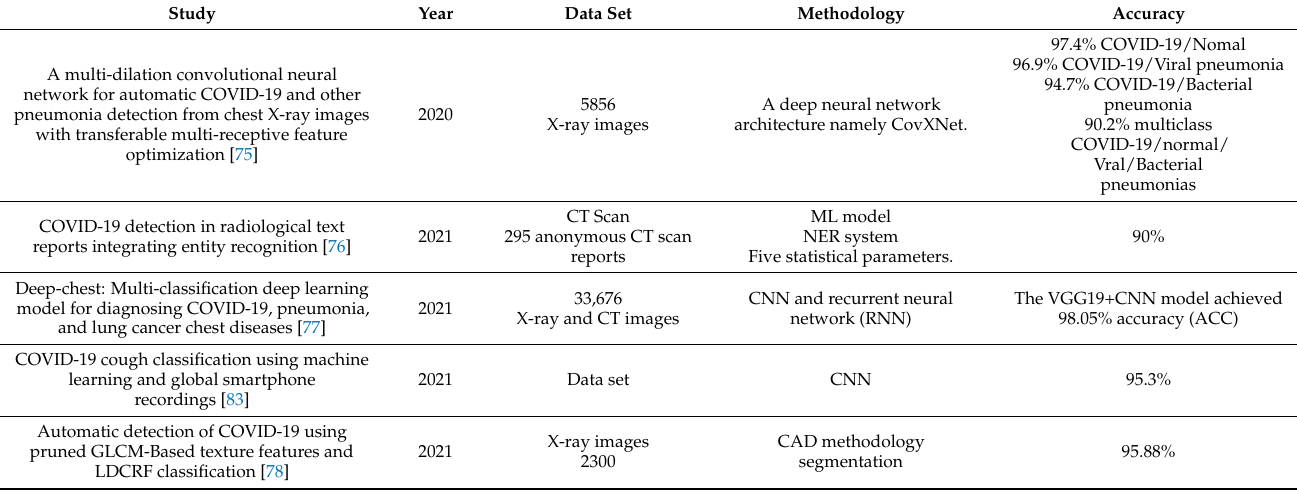
Table A1. Summary of existing AI systems for COVID-19